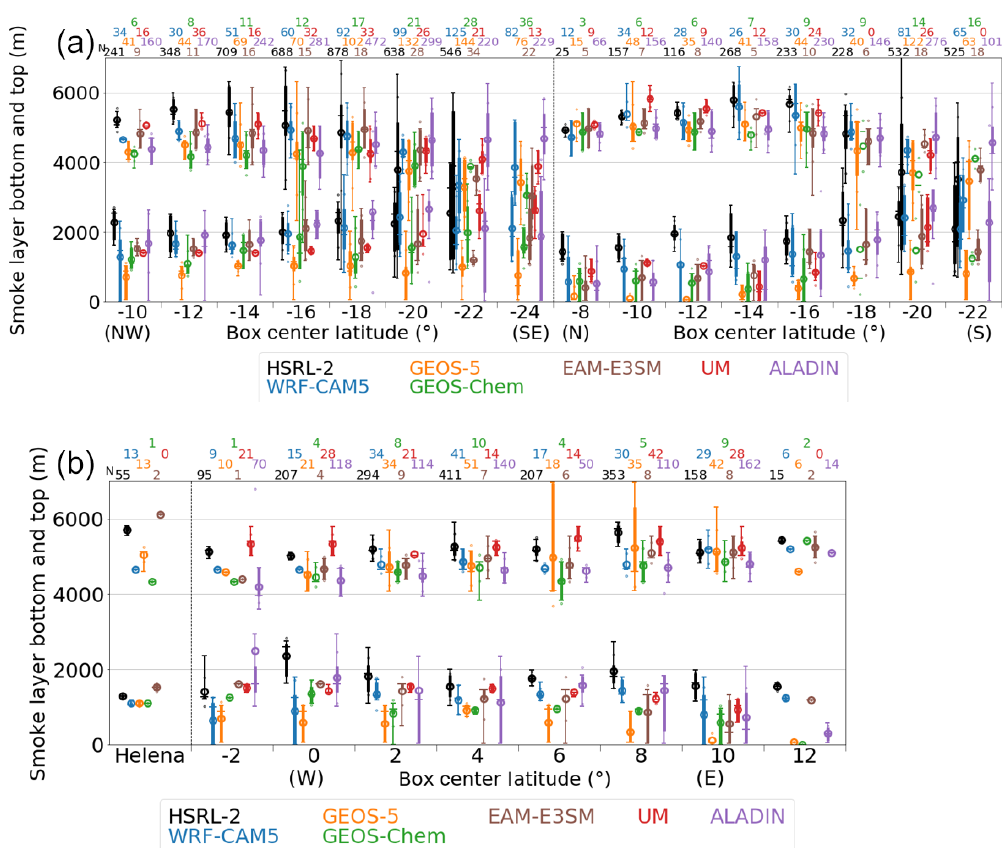
Figure 5. Smoke layer bottom and top altitudes. Smoke layers are identified through HSRL-2 backscatter intensities exceeding 0.25Mm − 1 sr − 1 , ALADIN extinction coefficient exceeding 17Mm − 1 and, for other models, BC mass concentration exceeding 200ngm − 3 ; see Sect. 2.1 for details. Panel (a) is for the diagonal and meridional corridors, while (b) is for Saint Helena island and the zonal corridor; see Sect. 3.2 and Fig. 2. In each box, the bars indicate the observations from the ER2 aircraft (black) and model products (colors). See Fig. 4 for a description of each bar and number. The model values presented here are sampled along the longitude, latitude, and time of the flights. Missing box whiskers indicate products